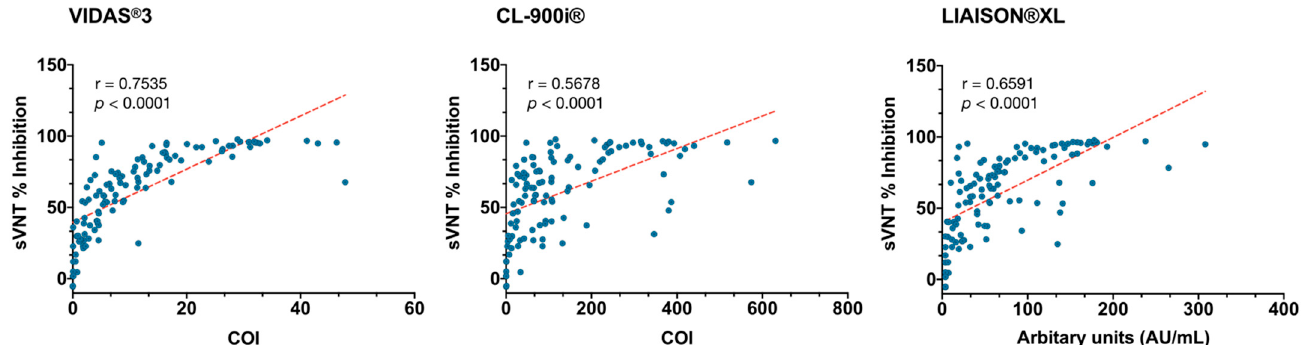
Figure 5. Pairwise correlational analysis of the assay numerical values obtained by each automated assay. Correlation plots of each automated assay with the sVNT. Pearson correlation coefficient (r) and p -value are indicated. Pearson’s r of 0–0.19 is regarded as very weak, 0.2–0.39 as weak, 0.40–0.59 as moderate, 0.6–0.79 as strong and 0.8–1 as very strong correlation, but these are rather arbitrary limits, and the context of the results should be considered. Data are presented for 111 RT-PCR confirmed SARS-CoV-2 positive samples and 127 known negative samples, run on each automated assay; VIDAS ® 3, CL-900i ® SARS-CoV-2, and LIAISON ® XL.